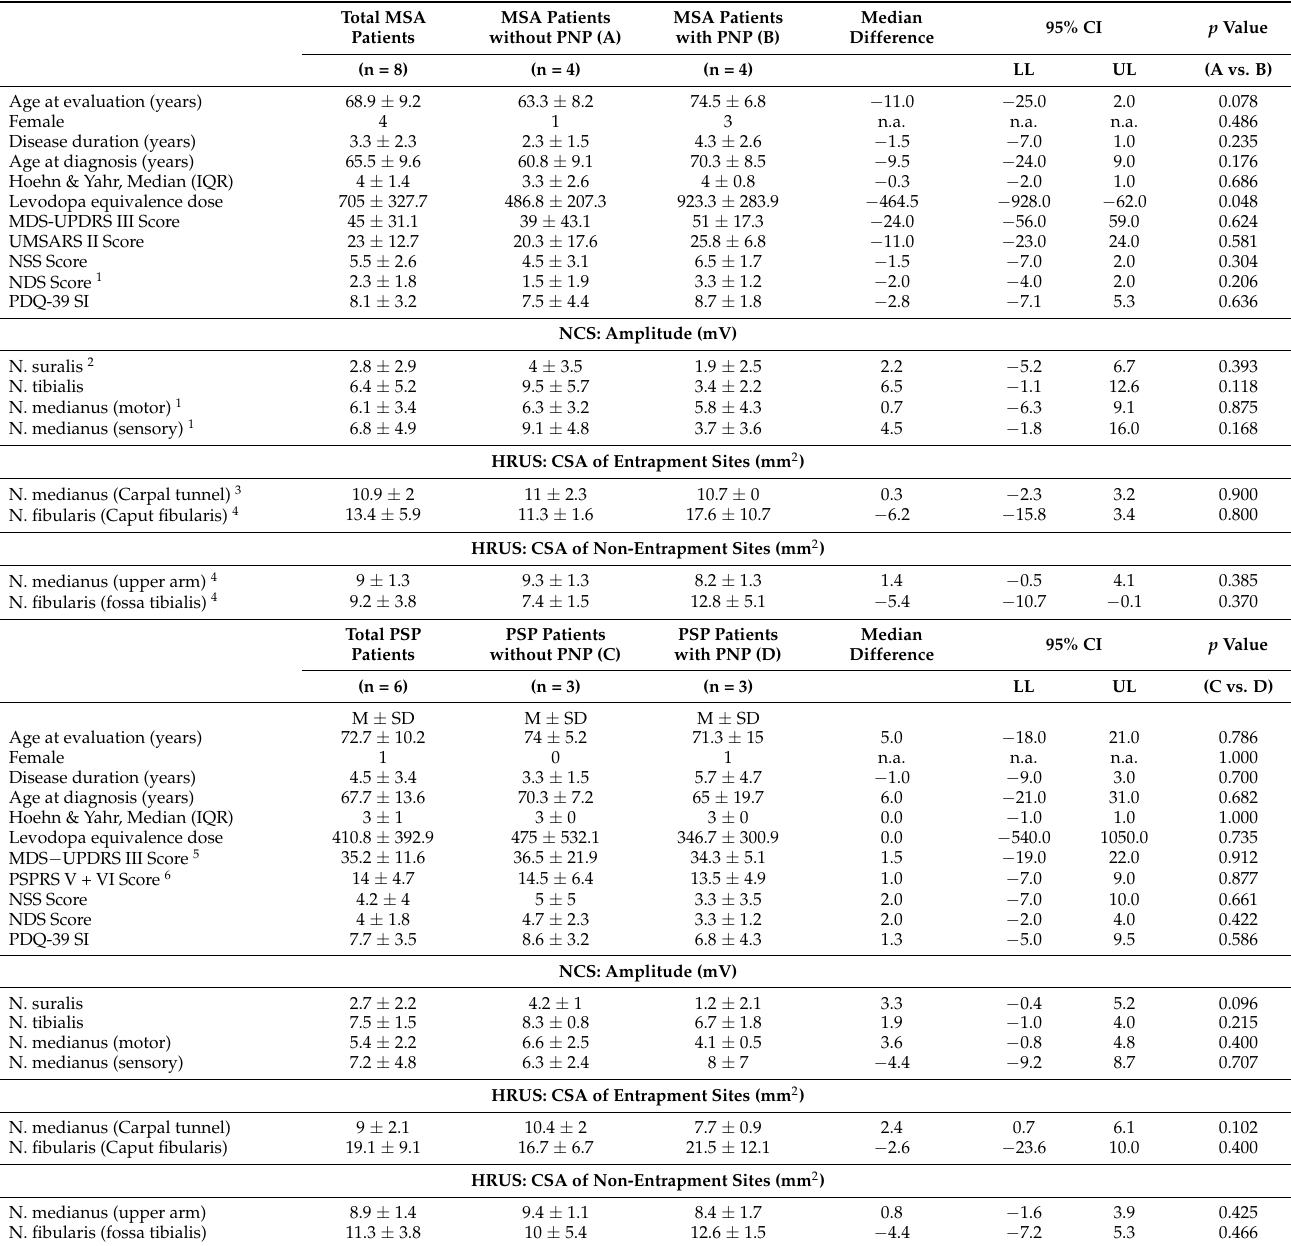
Table 1. Demographical, clinical and instrument-based analysis of MSA and PSP patients, subdivided into groups with/without electrophysiologically confirmed polyneuropathy, and findings of high-resolution ultrasound examination at entrapment and non-entrapment